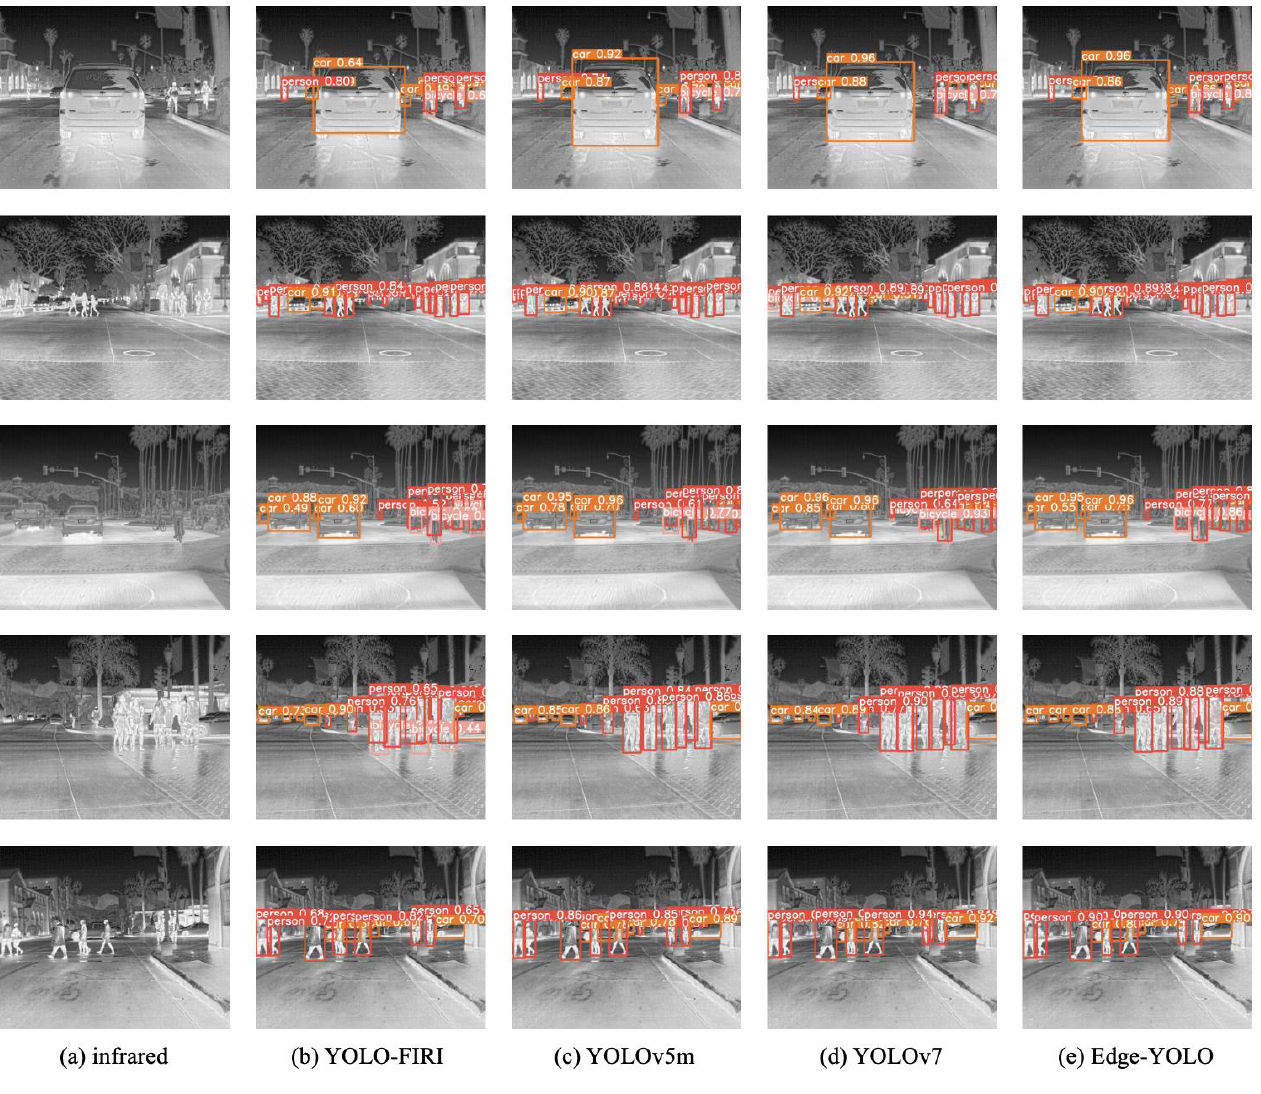
Figure 8. Part of the test